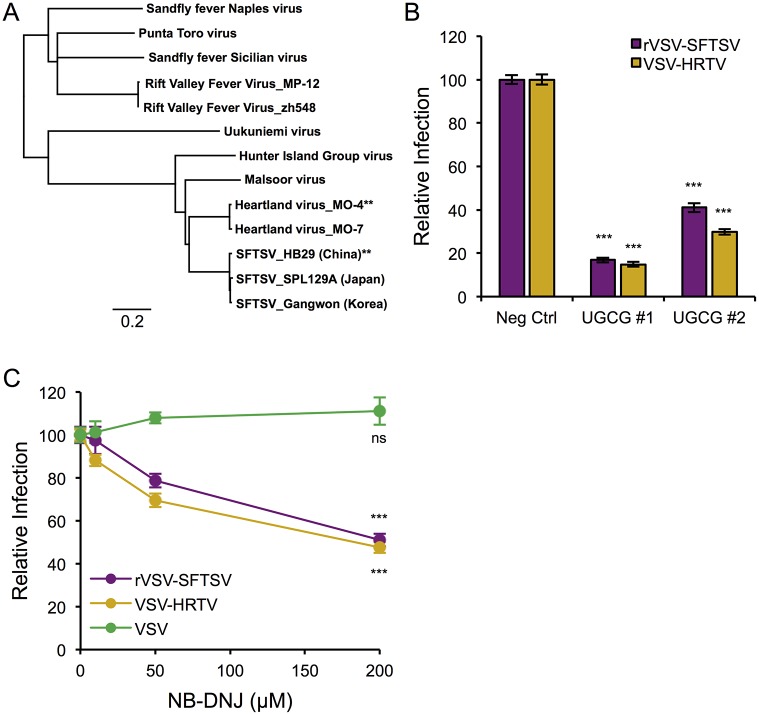
Heartland virus, close relative of SFTSV, also requires UGCG for efficient entry.(A) Phylogenetic tree based on the amino acid alignments of various phlebovirus glycoproteins (polyprotein precursor). Scale bar represents genetic distance as a percent difference (0.2 = 20%). Asterisks denote virus sequences used to generate codon-optimized M segments (GN-GC) for the present study. (B) U-2 OS cells were transfected with siRNAs to UGCG or a non-targeting control, then 72 hours later were infected with rVSV-SFTSV or the VSV pseudotype bearing the Heartland virus glycoprotein (VSV-HRTV). Twelve hours post-infection cells were harvested, immunostained for VSV M, and analyzed by flow cytometry. Percent infection was normalized to samples receiving the negative control siRNA and expressed as relative infection. Mean ± S.E.M. for 3 independent experiments. (C) U-2 OS cells were pre-treated with NB-DNJ for 48 hours before infection with rVSV-SFTSV, VSV-HRTV or VSV. Drug was kept in the media throughout the infection. Twelve hours post-infection cells were harvested, immunostained for VSV M, and analyzed by flow cytometry. Percent infection was normalized to the untreated control for each virus and expressed as relative infection. Mean ± S.E.M. for 3 independent experiments. *** p<0.001 using Student’s t-test with Bonferroni correction.